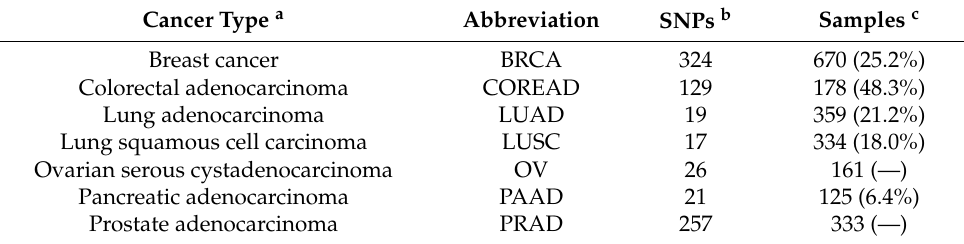
Table 1. Genetic variants used in association analyses with cancer risk for each of the common